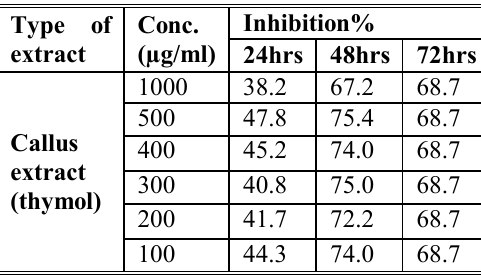
Table 2: A comparison of growth inhibition percentage of Hep-2 cell line, by using different concentration of callus extracts of Nigella sativa during three periods of